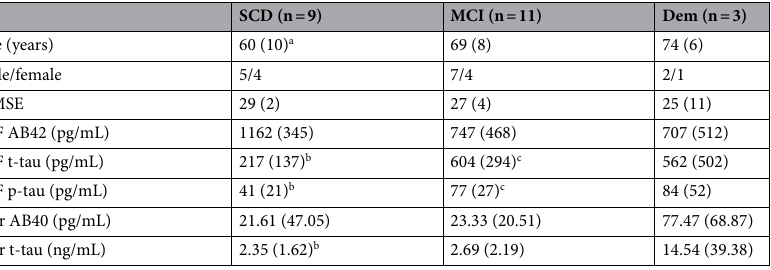
Table 3. Demographic and clinical characteristics and tear biomarkers of the CSF group. Data are shown as median (interquartile range). MMSE Mini-Mental State Examination, CSF cerebrospinal fluid. a p < 0.01 or Fisher exact test, Tear AB38, tear AB42 and tear p-tau were excluded due to n < 3 in the CSF group.